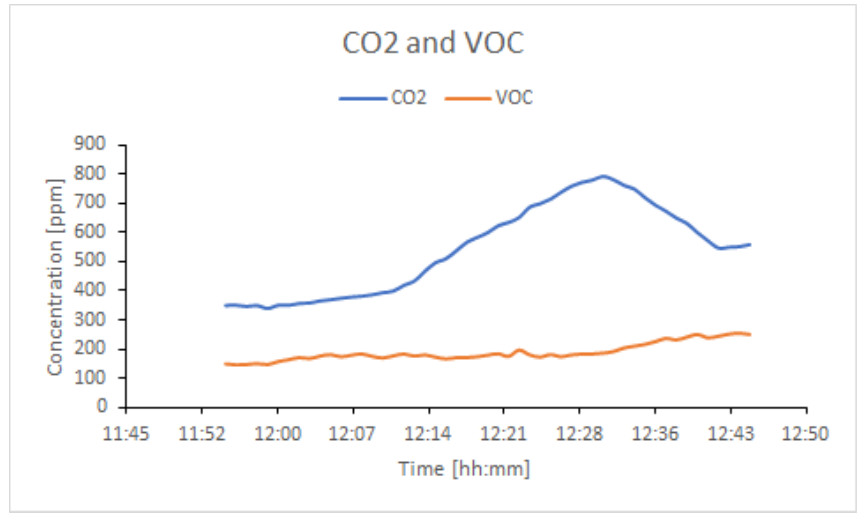
Figure 3. Concentration of CO 2 and VOX in the laboratory.